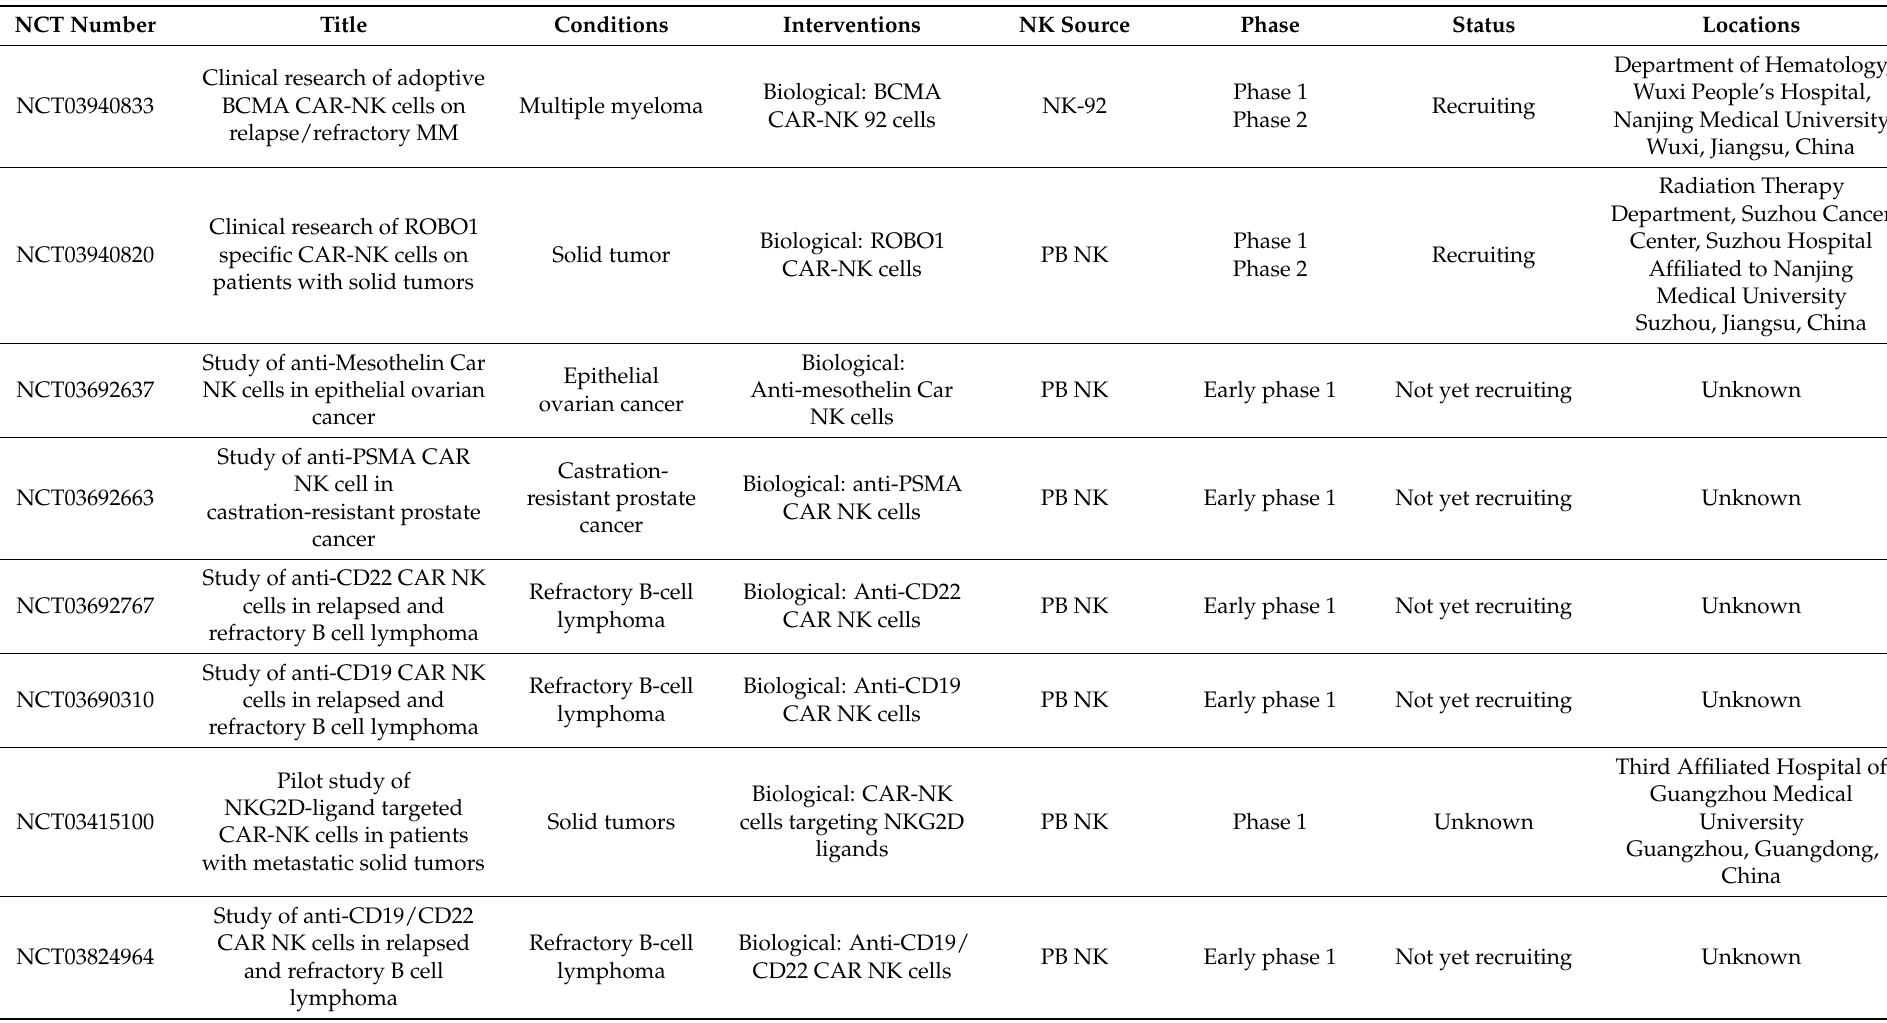
Table 2. Clinical study of CAR-NK in hematological and solid